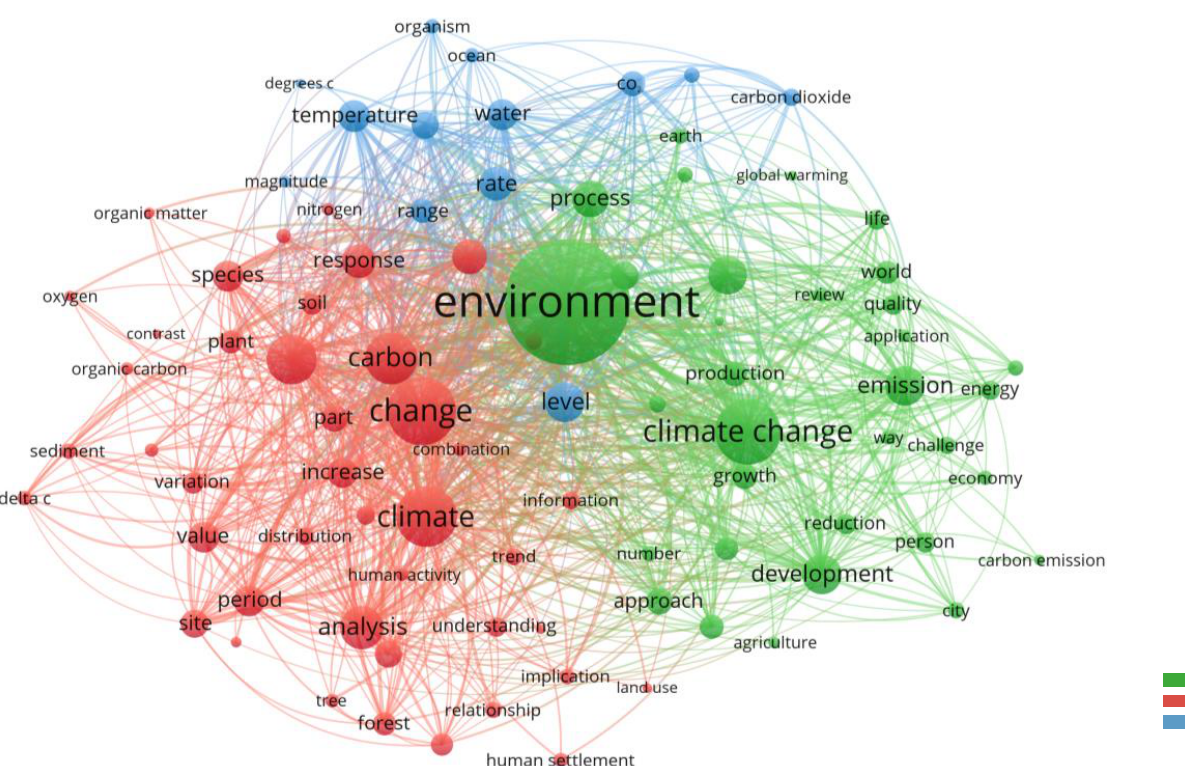
Figure 7. RCHSCC keyword co-occurrence network mapping.